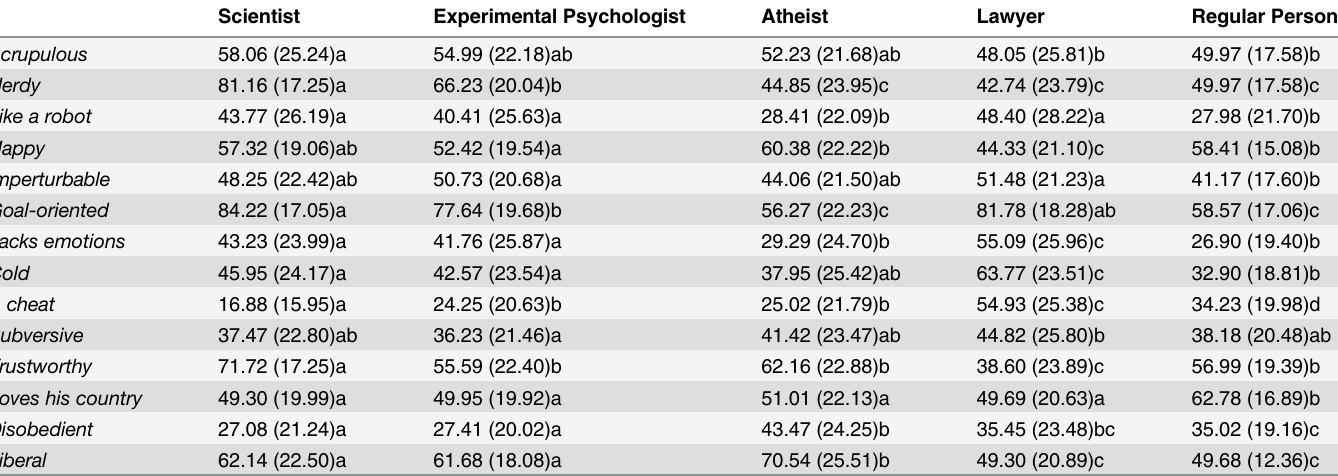
Table 1. Stereotypes of scientist, experimental psychologist, atheist, lawyer, and regular person targets in Study 9. All scales ranged from 1 ( totally disagree ) to 100 ( totally agree ). SD ’ s in